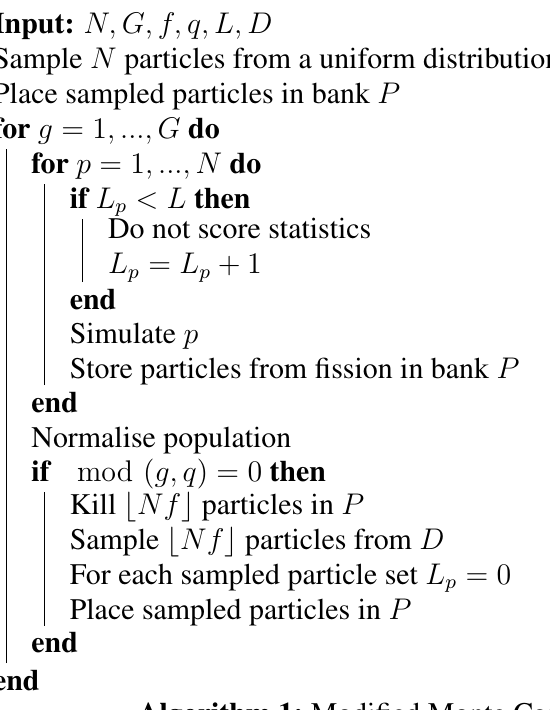
Algorithm 1: Modified Monte Carlo algorithm with particle